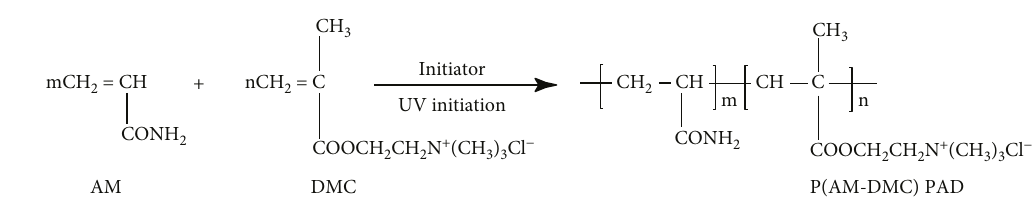
Figure 1: The preparation scheme of UV-initiated template